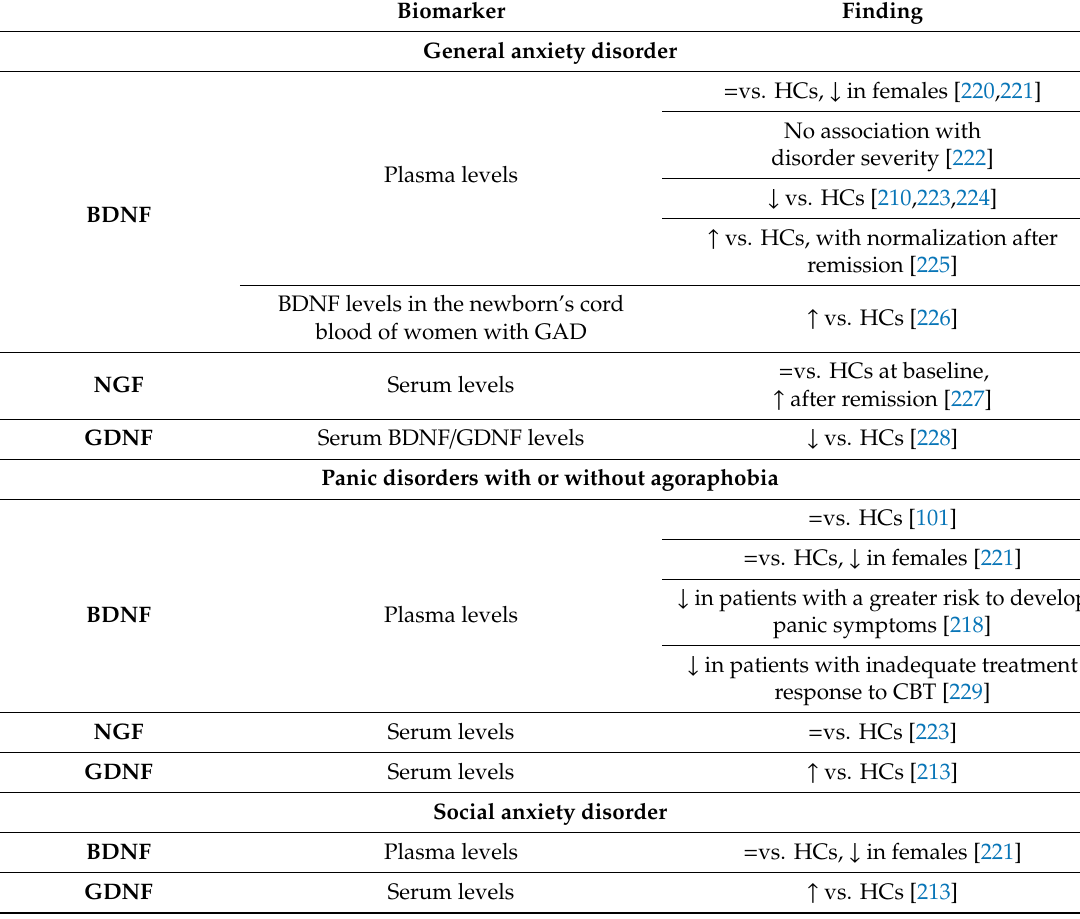
Table 4. Summary of the findings related to the neurotropic factors involved in GAD, PDA, and SAD.